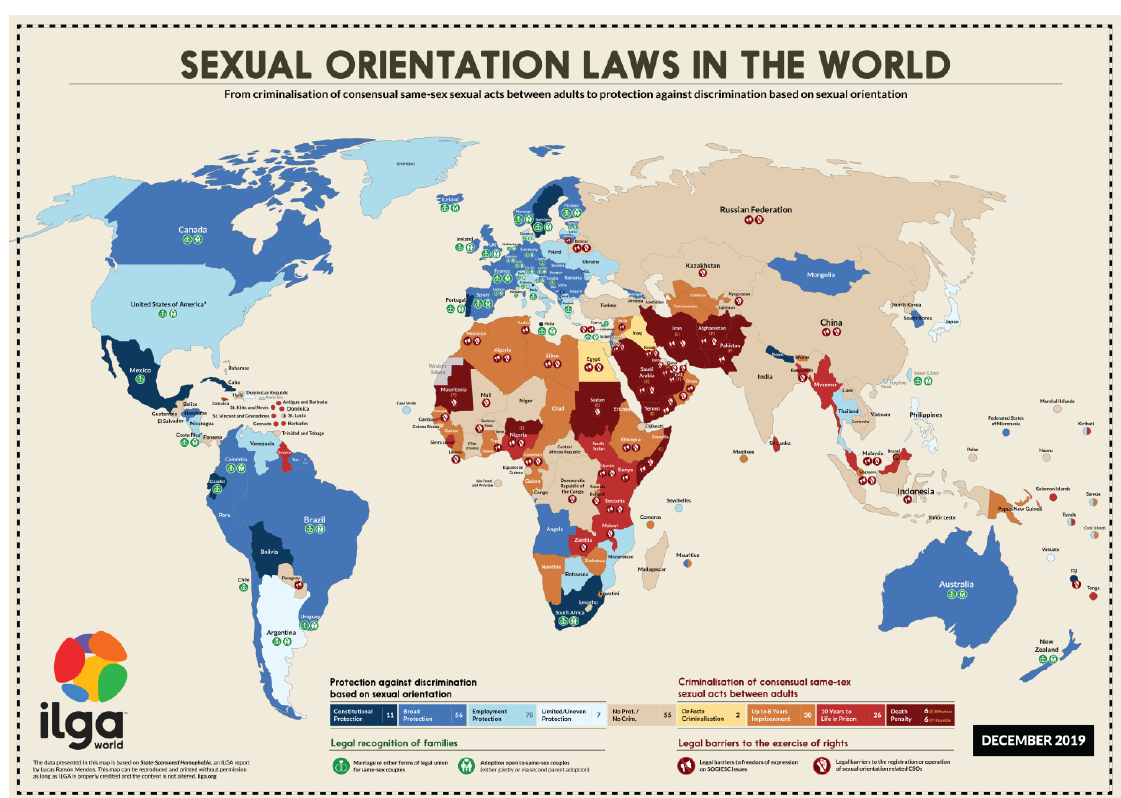
Figure A2. World map on sexual orientation laws (ILGA World 2020).